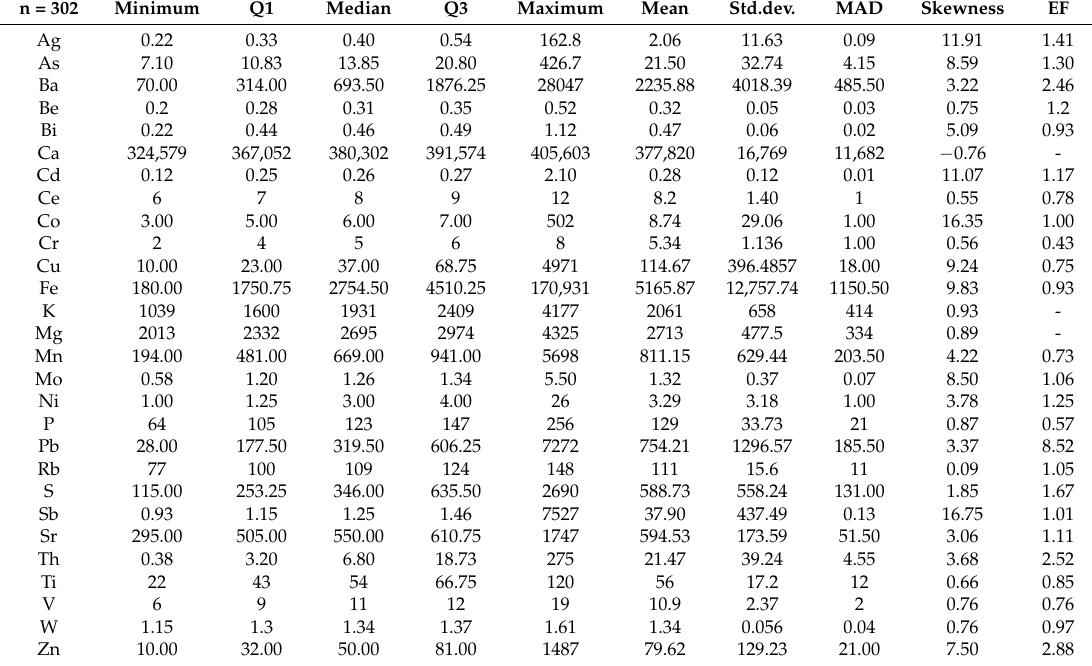
Table 2. Statistical parameters for surface samples from Block A of the Ravanj deposit (in ppm). n, number of samples; Q1, 1st quartile; Q3, 3rd quartile; MAD, median of absolute deviation from data median; EF, enrichment